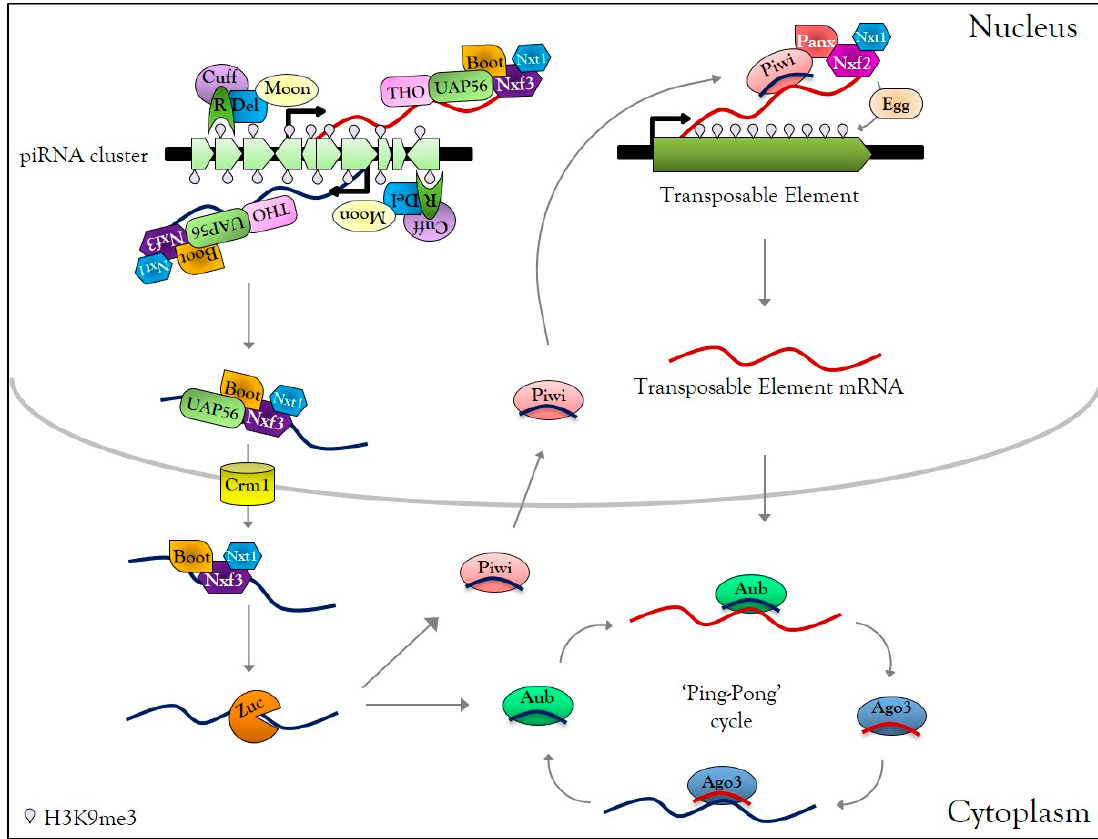
Figure 1. Germline PIWI-interacting RNAs (piRNA) biogenesis. In Drosophila melanogaster germ cells, active piRNA clusters are enriched in H3K9me3 and HP1-like protein Rhino (R), which interact with Deadlock (Del), Cuto ff (Cu ff ). Moonshiner (Moon) interacts with Del and recruits transcription initiation factors, allowing transcription of piRNA clusters in the sense and antisense direction. Bootlegger, UAP56, the THO complex, Nxt1, Nxf3 are recruited to the piRNA cluster transcription site. The transcripts are then exported to the cytoplasmic piRNAs biogenesis site via the CRM1 exportin. In the cytoplasm, piRNA precursors are cleaved by Zucchini (Zuc) into primary piRNA and charged by Piwi or Aubergine (Aub) proteins, forming Piwi-piRISC and Aub-piRISC complexes. Piwi-piRISC is translocated into the nucleus and recognizes nascent TE transcripts due to the interaction with Panoramix, the Nxf2, and Nxt1. The association of these factors to nascent TE transcripts causes recruitment of the histone methyltransferase Eggless that transcriptionally silences TEs by local heterochromatinization. In the cytoplasm, Aub-piRISC cleaves TE transcripts into secondary piRNAs, which are loaded onto Ago3, forming Ago3-piRISC complexes. Ago3-piRISC recognizes and cleaves piRNA precursors into new secondary piRNAs, loaded onto Aub. This mechanism, known as the ‘Ping-Pong’ cycle, allows the amplification of piRISC complexes and post-transcriptional regulation of TEs.